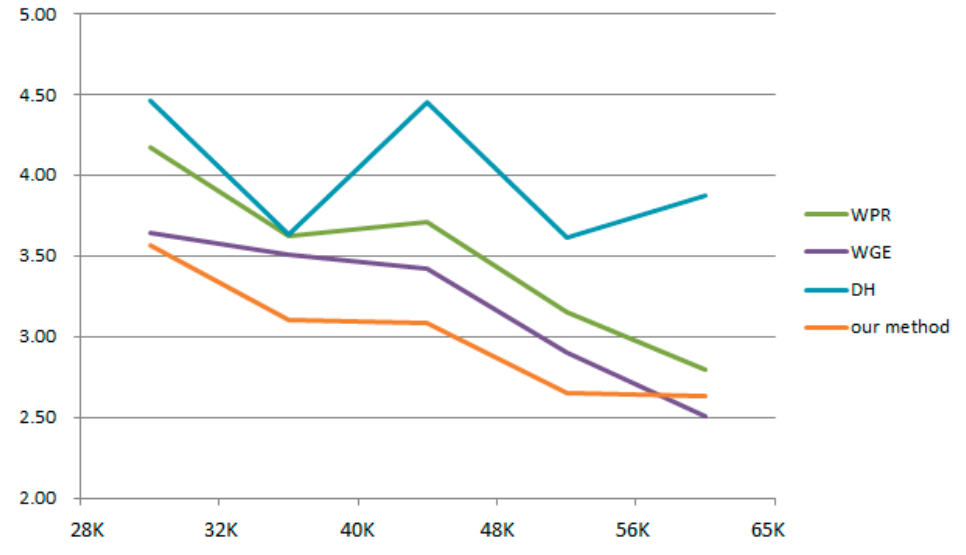
Figure 9. Curve diagram of different color temperature intervals.